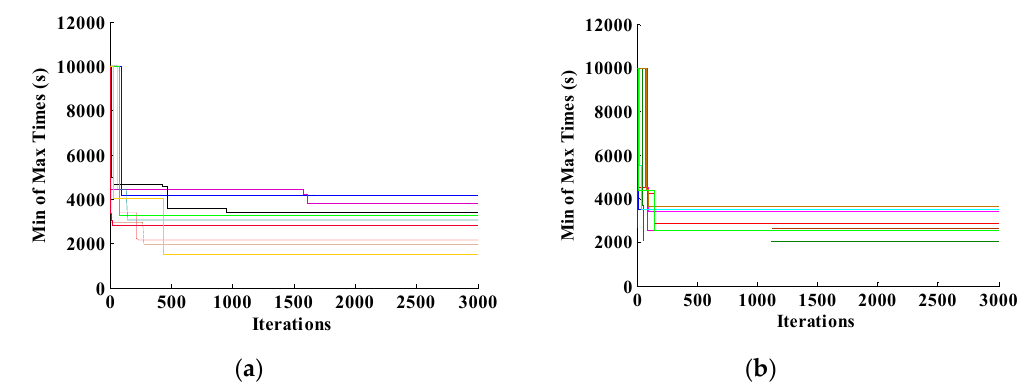
Figure 7. The progression of searching the optimal solution for t occ > 150 s: ( a ) for ρ = 0.1; ( b ) ρ = 0.5.